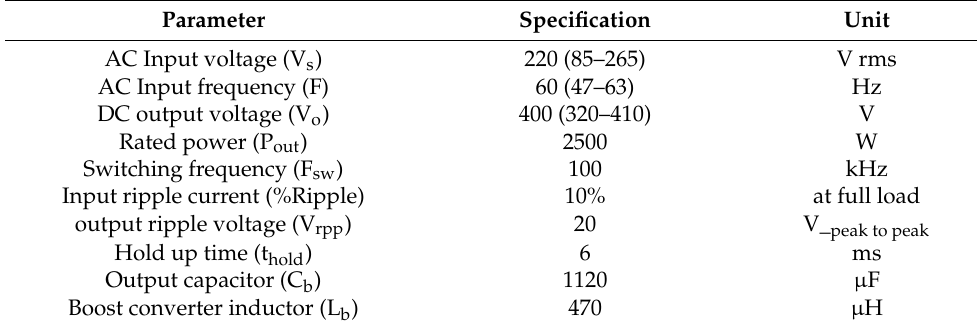
Table 1. Telecom CCM-PFC converter design specifications and components